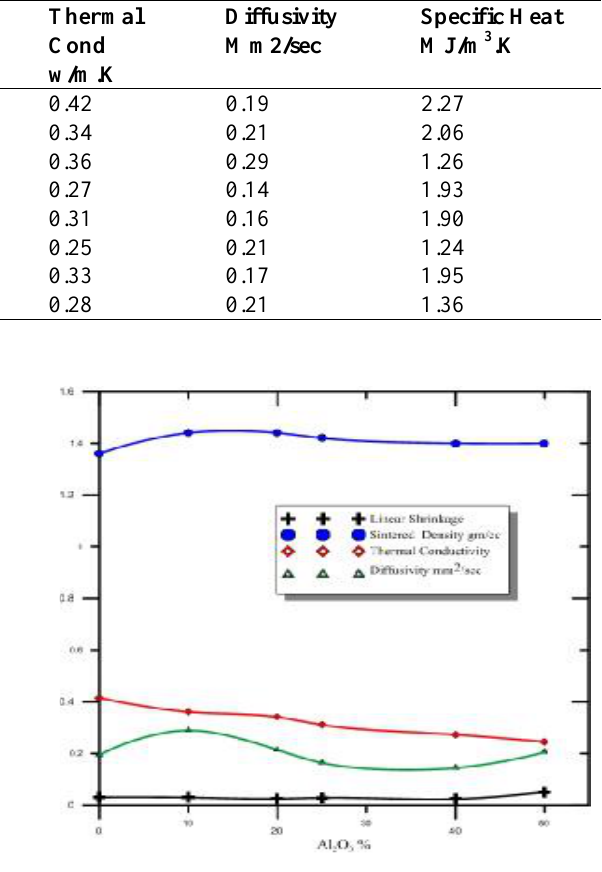
Fig. 6. The linear shrinkage, sintered density, Fig. 7. The linear shrinkage, sintered density,